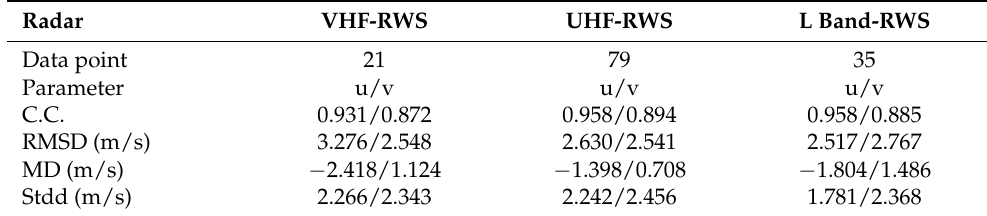
Figure 9. Comparisons of radar-measured horizontal wind velocities and radiosonde wind for zonal ( upper ) and meridional ( lower ) wind components in clear air conditions. The dashed black line is the diagonal line, and the solid red line is the linear fit to the data. Table 4. Comparisons of zonal wind (u) and meridional wind velocity (v) between wind profilers and rawinsonde (RWS).